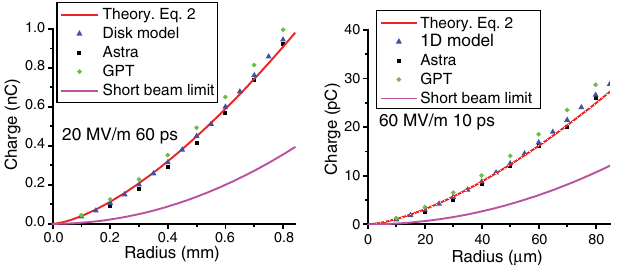
FIG. 2 (color online). Charge extracted as a function of radius. Disk model, three-dimensional simulations (A STRA and GPT) and theory ( C c ¼ 1 ) for two different cases.